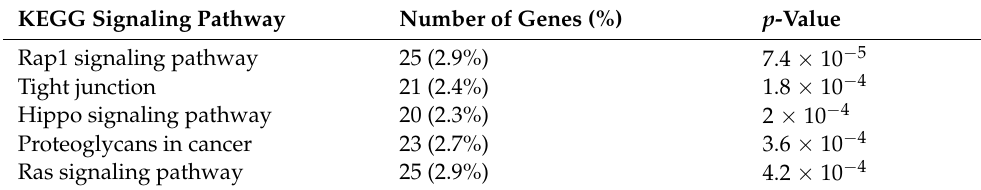
Table 1. KEGG pathway enrichment analysis of